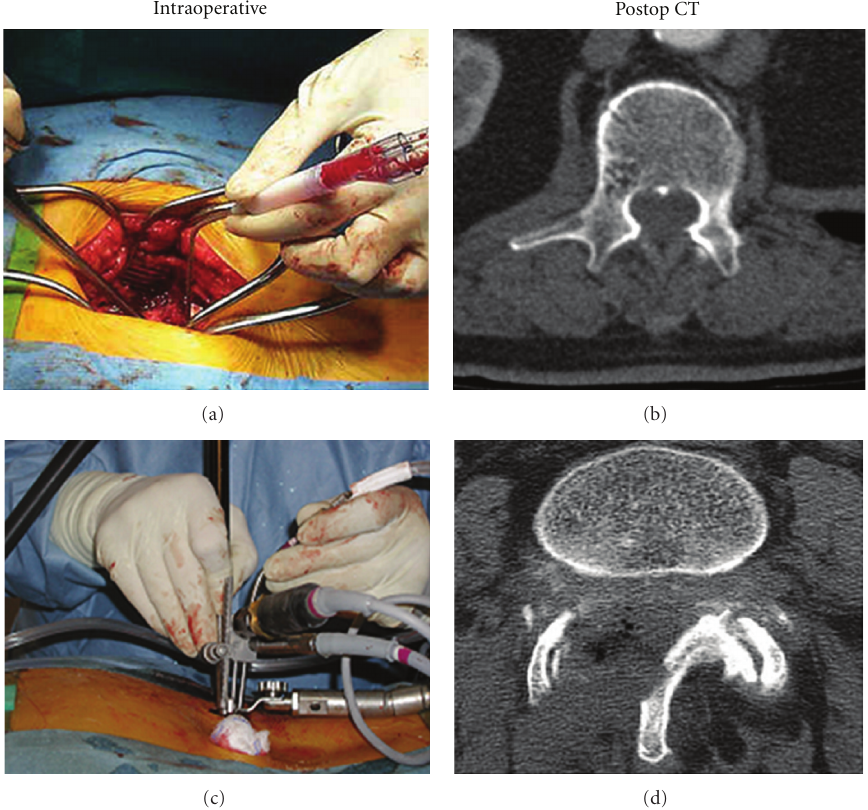
Figure 1: Illustrations of intraoperative surgical exposure and postoperative cross-sectional CT of lumbar spine with spinal canal decompression. Open laminectomy (a) and (b). Minimally invasive microendoscopic decompression (c) and